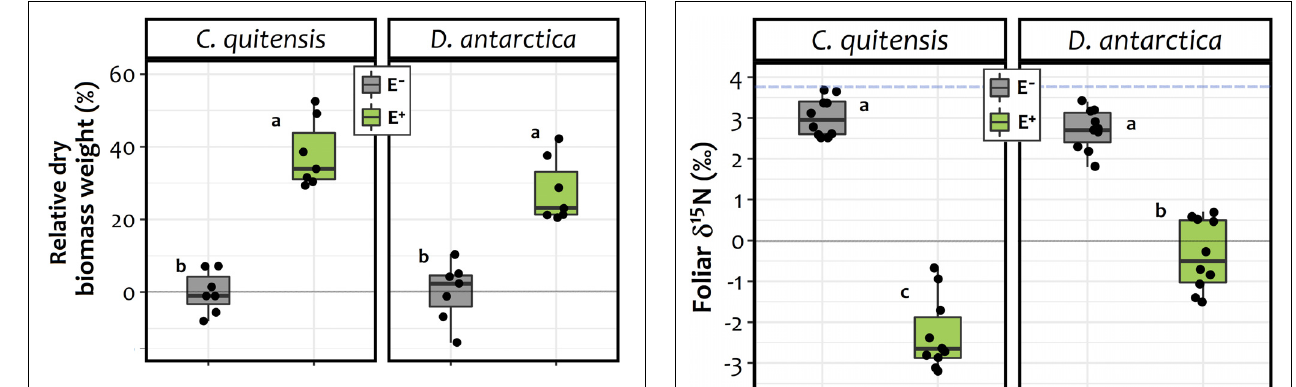
FIGURE 3 | Biomass increase percentage of endophyte free (E − , in gray) and endophyte-infected (E+, in green) individuals of C. quitensis and D. antarctica , expressed as the percentage of the average final dry biomass of the E − group of each species. Dots represent individual values ( n = 7), while boxplots the data inter-quartilic distribution per group. Different letters denote significant differences ( p < 0.05) between treatments and/or species, as determined by the Tukey a-posteriori pairwise comparison test.